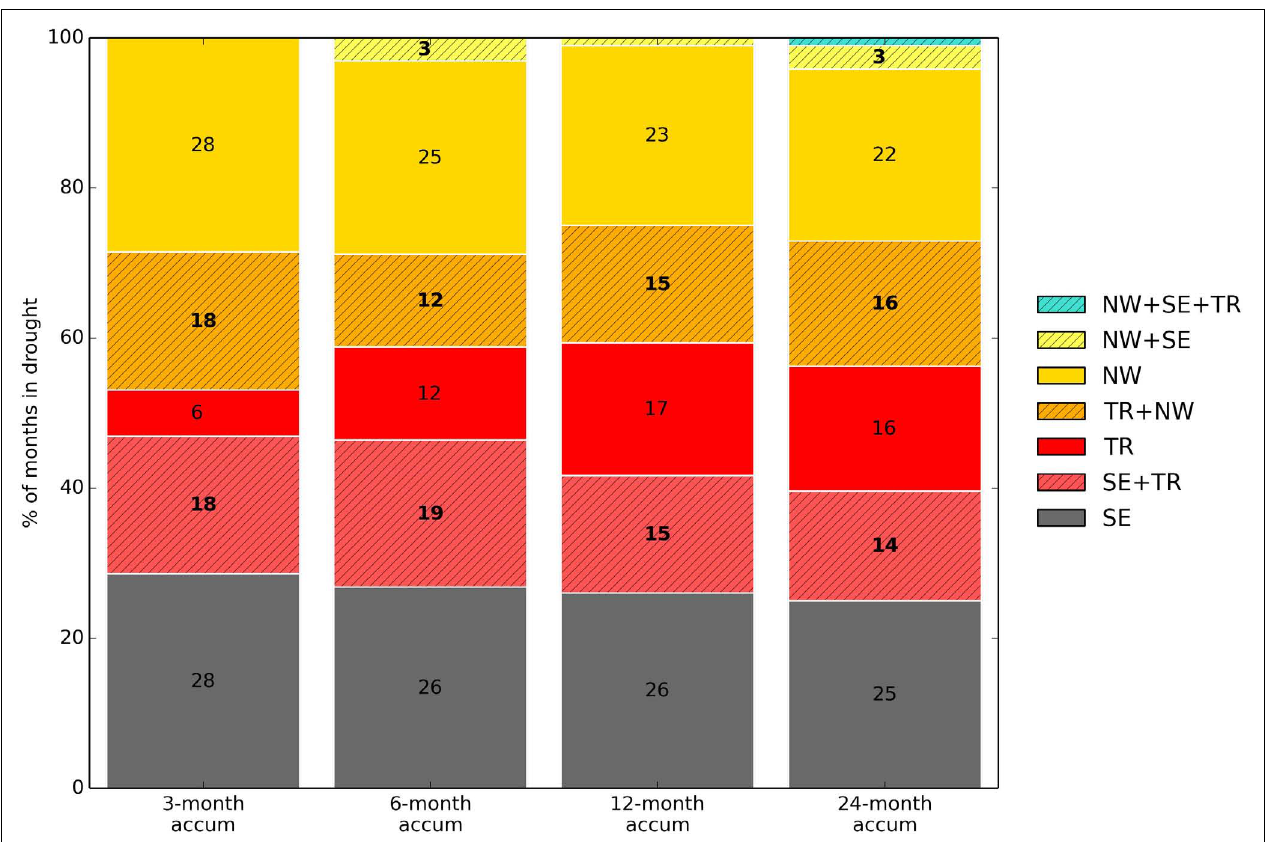
FIGURE 13 | Percentage of months in the most severe droughts affecting the three regions. The hatched area represents months in drought where multiple regions were affected simultaneously. “TR” in the legend stands for the Transition region. The “top 20” most severe droughts detected between 1862 and 2015 in each region were considered, for accumulation periods of 3, 6, 12 and 24